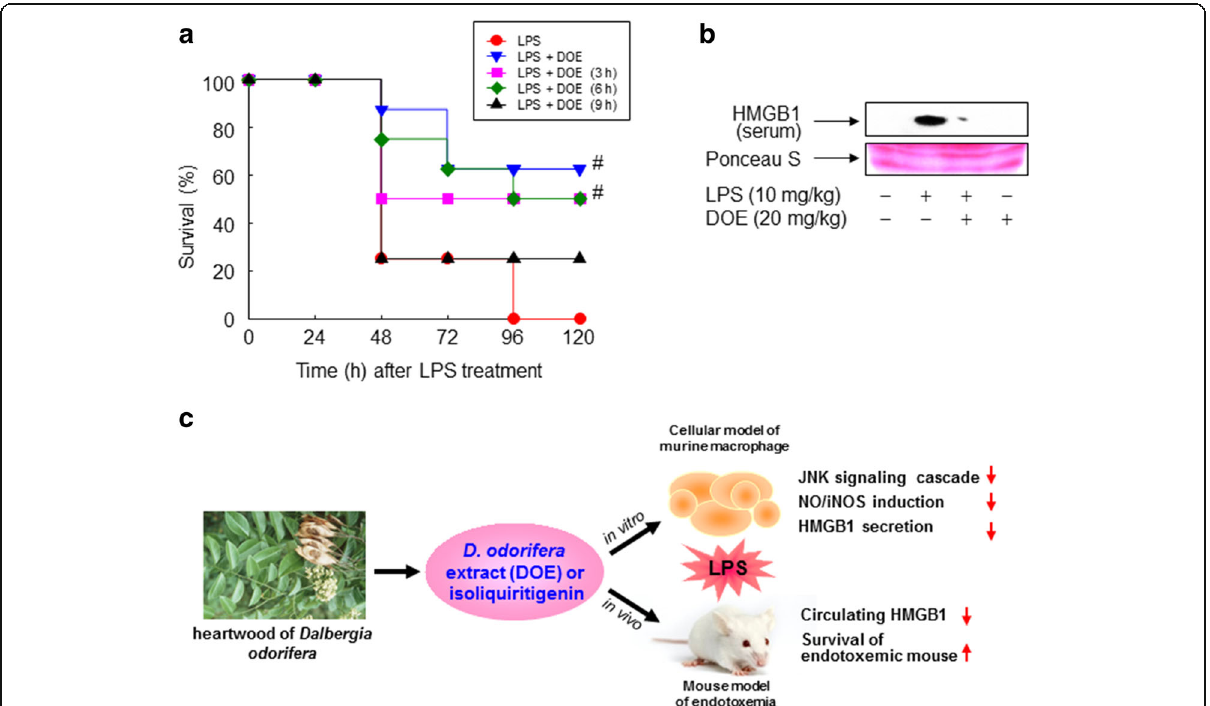
Fig. 9 DOE improves the survival rates of mice treated with endotoxin through blockade of HMGB1 release. a BALB/c mice ( n = 8 per group) were treated with LPS (10 mg/kg, i.p.) and then injected with a single dose of DOE (20 mg/kg, i.p.) 0, 3, 6, and 9 h later. Motality was monitored for up to 2 weeks every day. b BALB/c mice ( n = 4 per group) were treated with a single dose of DOE (20 mg/kg, i.p.) with or without a lethal injection of endotoxin (LPS, 10 mg/kg, i.p.). Circulating levels of HMGB1 were detected by immunoblot analysis of sera collected at 20 h post-LPS injection. As a loading control, Ponceau S staining was used. c Schematic representation of DOE-mediated inhibition of HMGB1 release. # , p < 0.01 vs LPS-treated